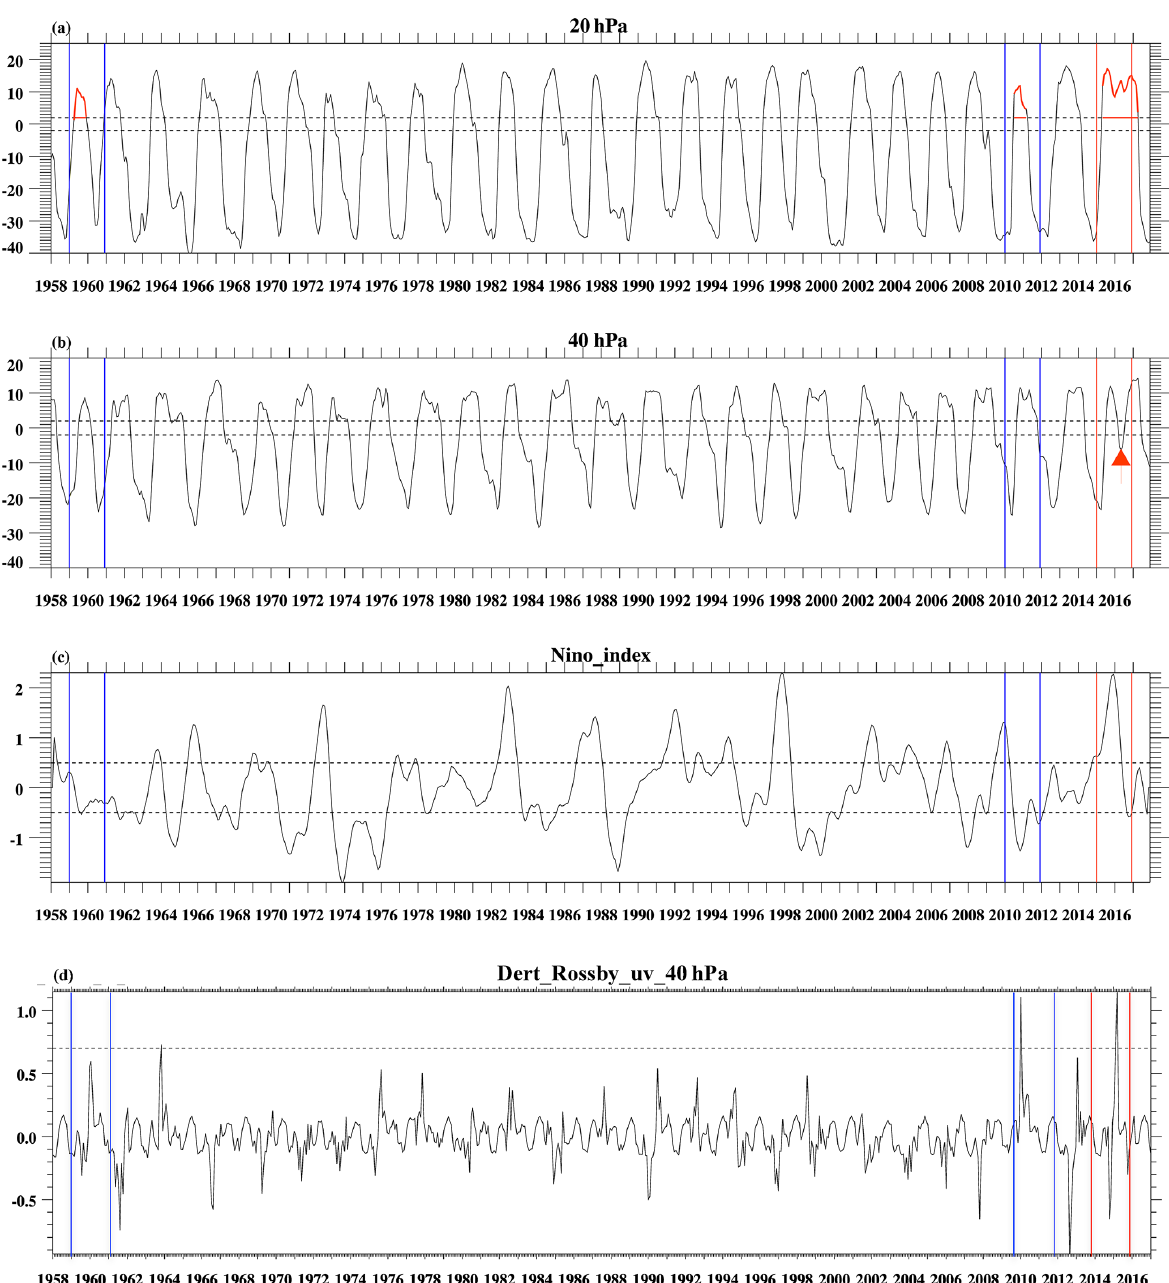
Figure 1. Zonal mean zonal wind at (a) 20hPa and (b) 40hPa; (c) ENSO index in the Niño 3.4 region. Panel (d) denotes the time series of the horizontal Rossby wave momentum flux anomaly with respect to the monthly climatology averaged over the tropics (from 10 ◦ S to 10 ◦ N) at 40hPa from 1958 to 2017 (unit is m 2 s − 2 ). The horizontal dashed lines denote the speeds of 2 and − 2ms − 1 in panels (a) and (b) . In panel (c) the horizontal dashed lines denote 0.5 and − 0 . 5K, respectively. The horizontal dashed line denotes the value of 0.7m 2 s − 2 in panel (d) . The vertical red lines denote the time period of 2015/2016, and the vertical blue lines denote the periods of 1959/1960 and 2010/2011. In panel (a) the horizontal red lines denote the westerly phase periods during 1959/1960, 2010/2011, and 2015/2016 at 20hPa. In panel (b) the red triangle denotes the reversed westerly zonal wind in 2015/2016 at